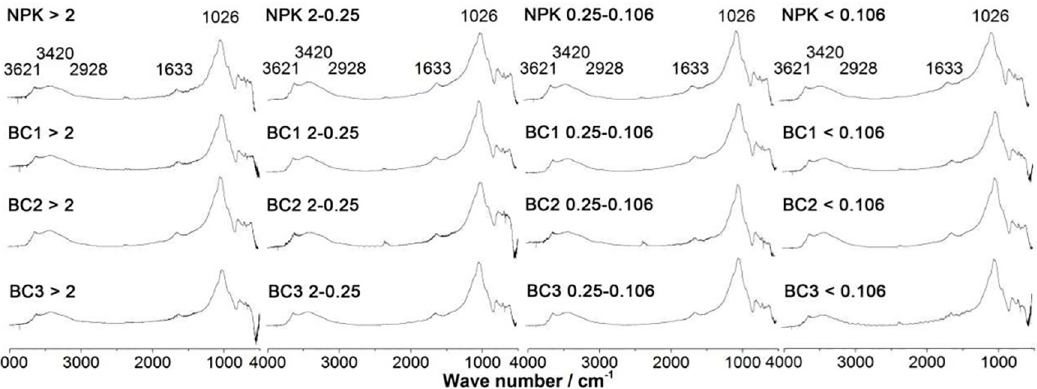
Fig 3. Effect of biochar content on organic carbon functional groups absorption spectra of soil samples.